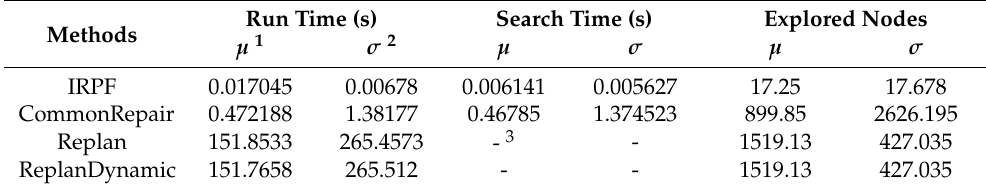
Table 1. Summary of statistics for the performance of different methods in the satellite system. Run Time (s) Search Time Methods